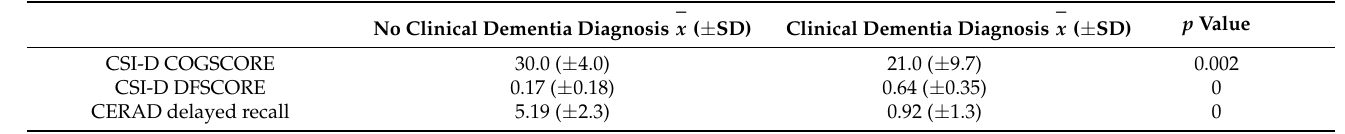
CSI-D = Community Screening Instrument for Dementia, CERAD = The Consortium to Establish a Registry for Alzheimer’s